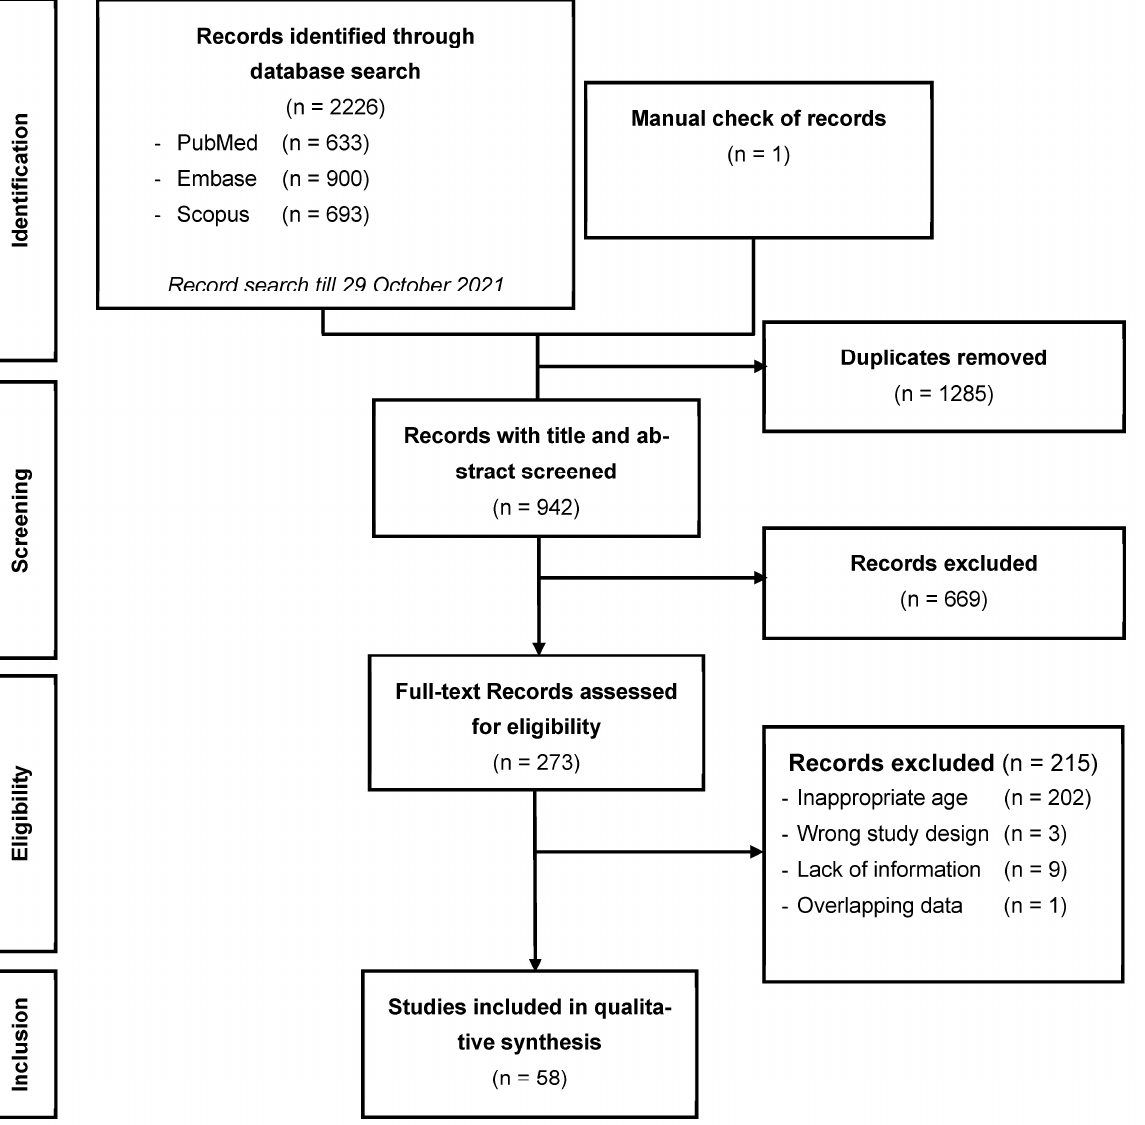
Figure 1. PRISMA fl ow diagram of the records included in the systematic review. Figure 1. PRISMA flow diagram of the records included in the systematic